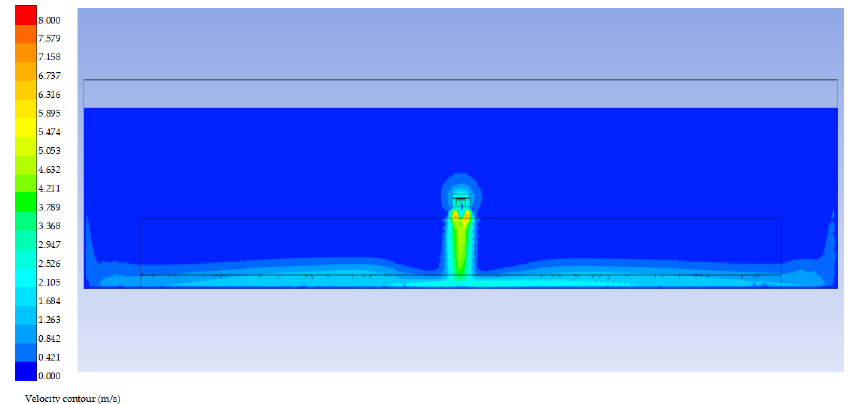
Figure 9. Velocity distribution of the X–Y plan.